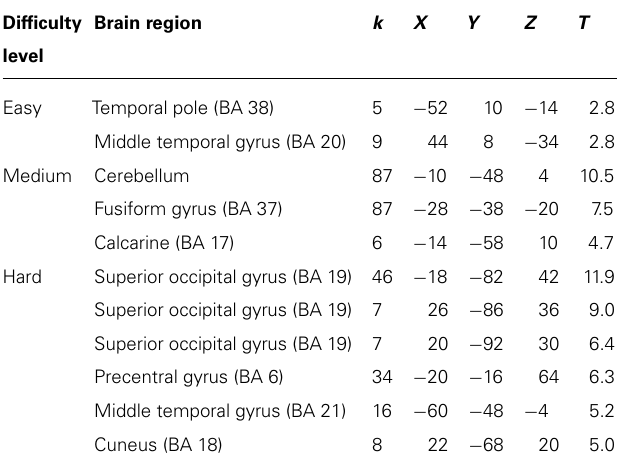
Table 1 | Brain regions and local maxima of clusters, recruited by novices during action observation of successful trials compared to unsuccessful